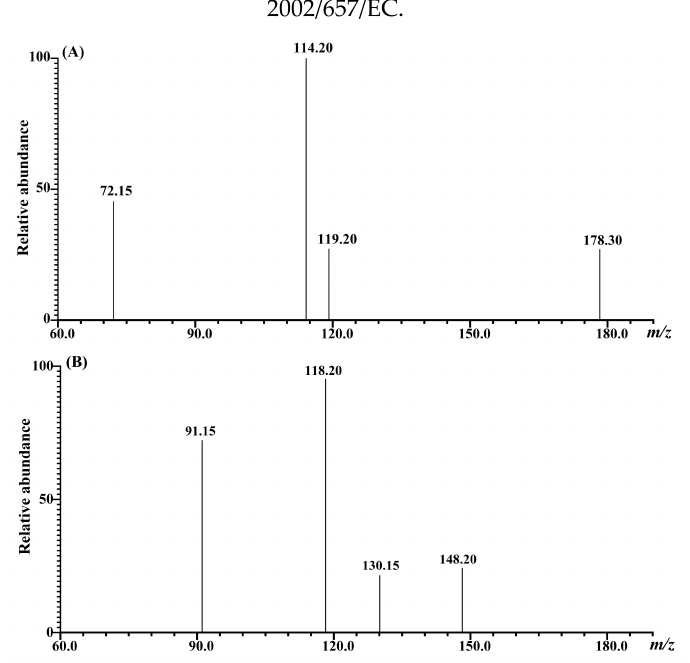
Figure 6. The product ions of sulforaphane and indole-3-carbinol obtained by UHPLC-MS/MS. ( A ) product ions of m / z 178.3 from sulforaphane standard; ( B ) product ions of m / z 148.2 from the indole-3-carbinol standard.